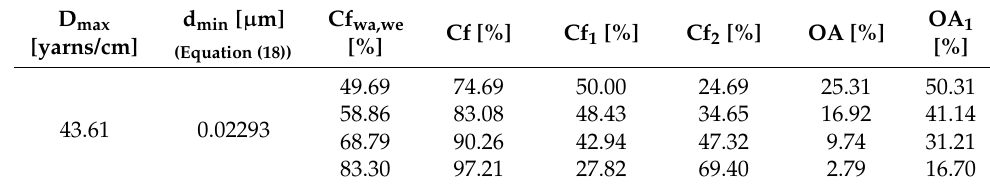
Table 5. D max and d min , calculated values of Cf, Cf wa , Cf we , Cf 1 , Cf 2 , and OA for CO samples.